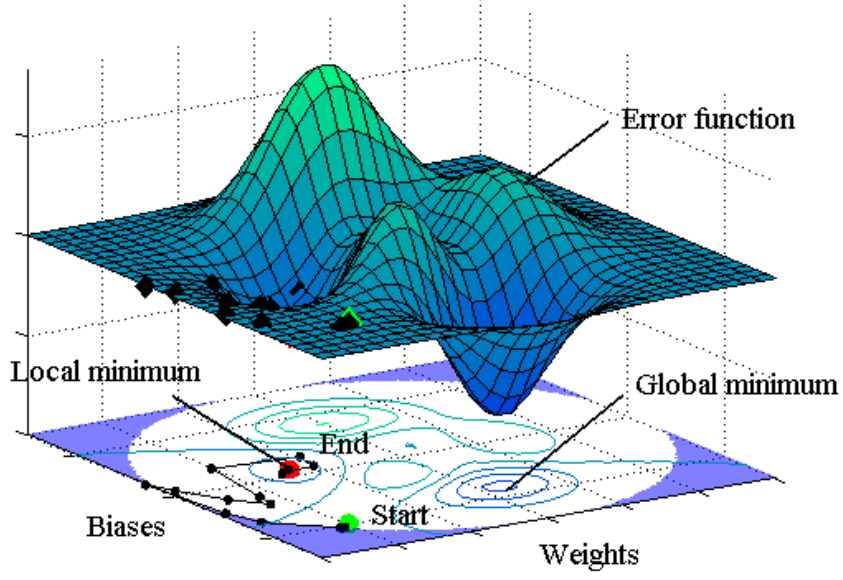
Figure 1. Illustration of local minimization problem.